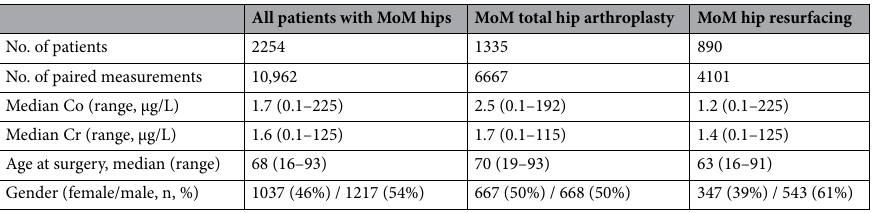
Table 1. Demographics of the patients from whom the whole blood cobalt and chromium samples were drawn. MoM, metal-on-metal; Co, cobalt; Cr, chromium.